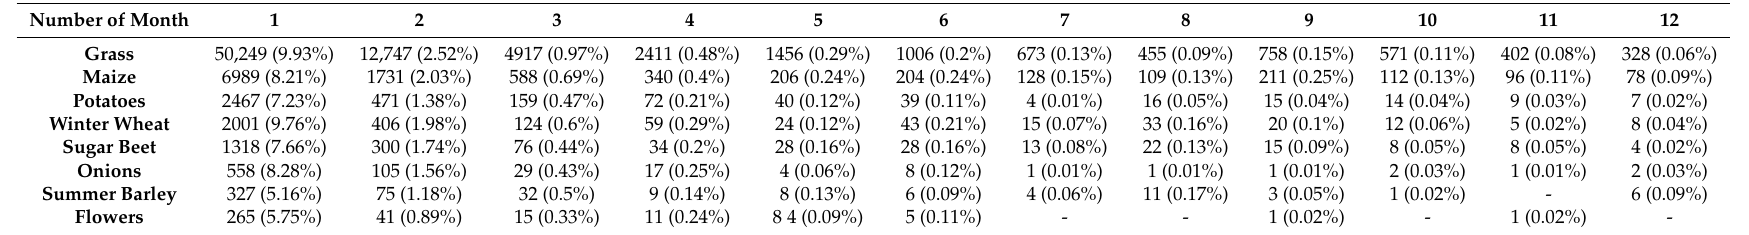
Table 4. Number of parcels and their monthly revisit frequency for each crop